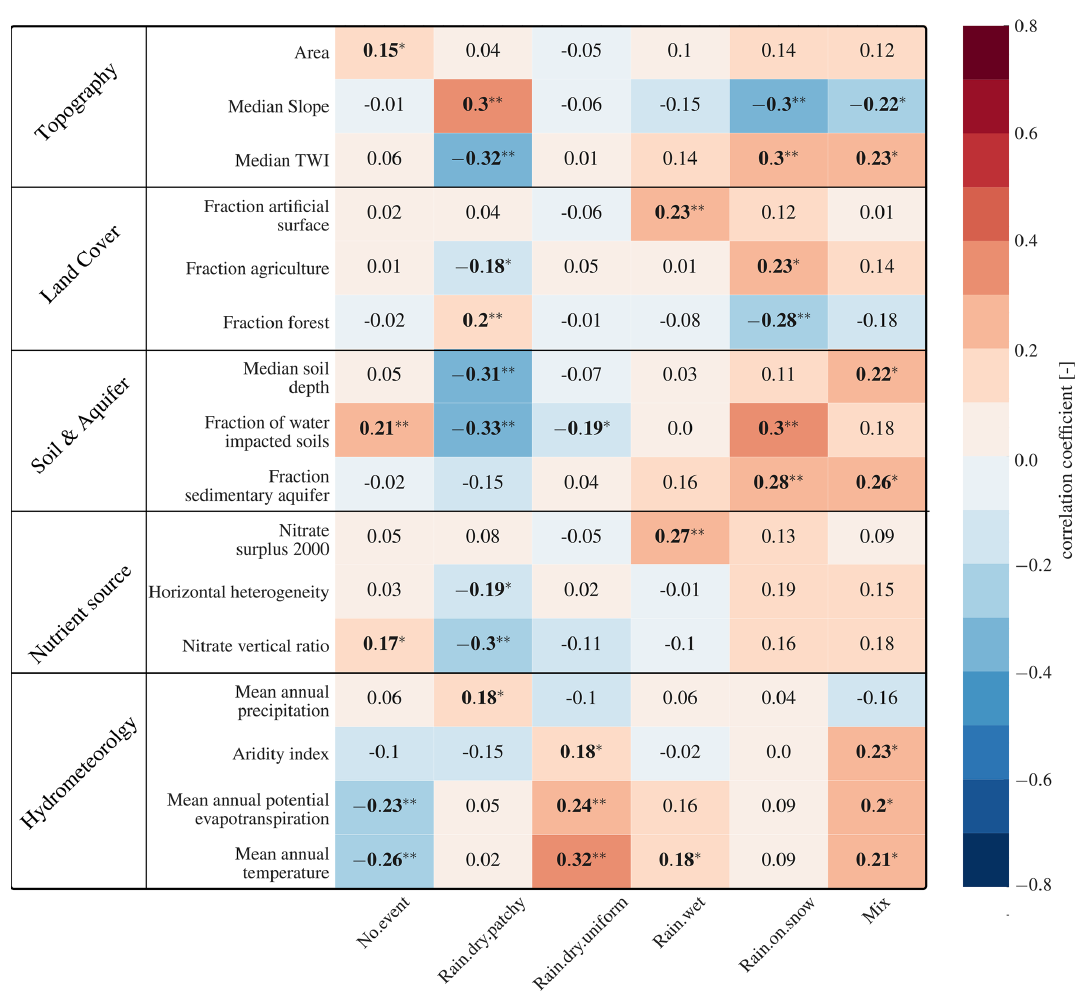
Figure 6. Spearman rank correlation coefficient between deviations of nitrate concentrations from the long-term C – Q relationships ( (cid:49) res50) of a particular event type across study catchments and catchment descriptors. Significant correlations are indicated by bold font and ∗ for p < 0.05 and ∗∗ for p <